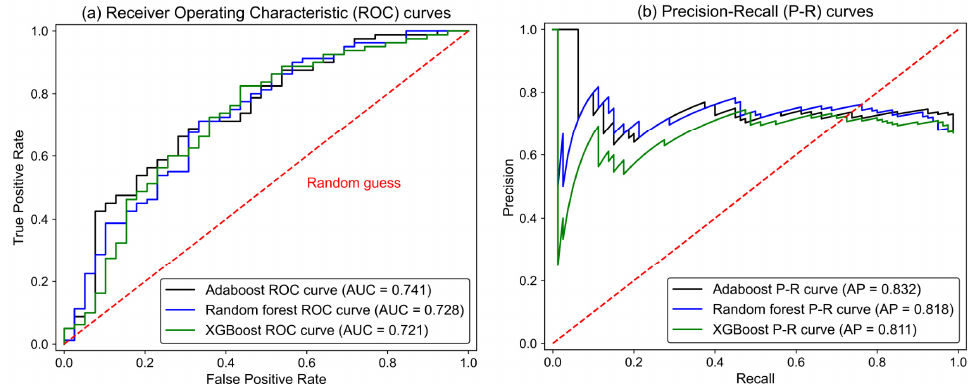
Figure A4. Receiver operating characteristic (ROC) curves and precision-recall (P-R) curves of results